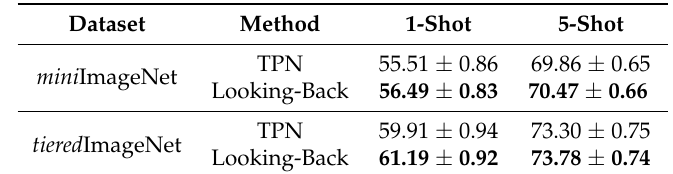
Table 3. Accuracy (in %) after training with higher shots. Here, the system evaluated on a 1-shot test set was trained in a 5-shot setting, and the system evaluated on a 5-shot test was trained in a 10-shot setting. Best results are shown in bold.